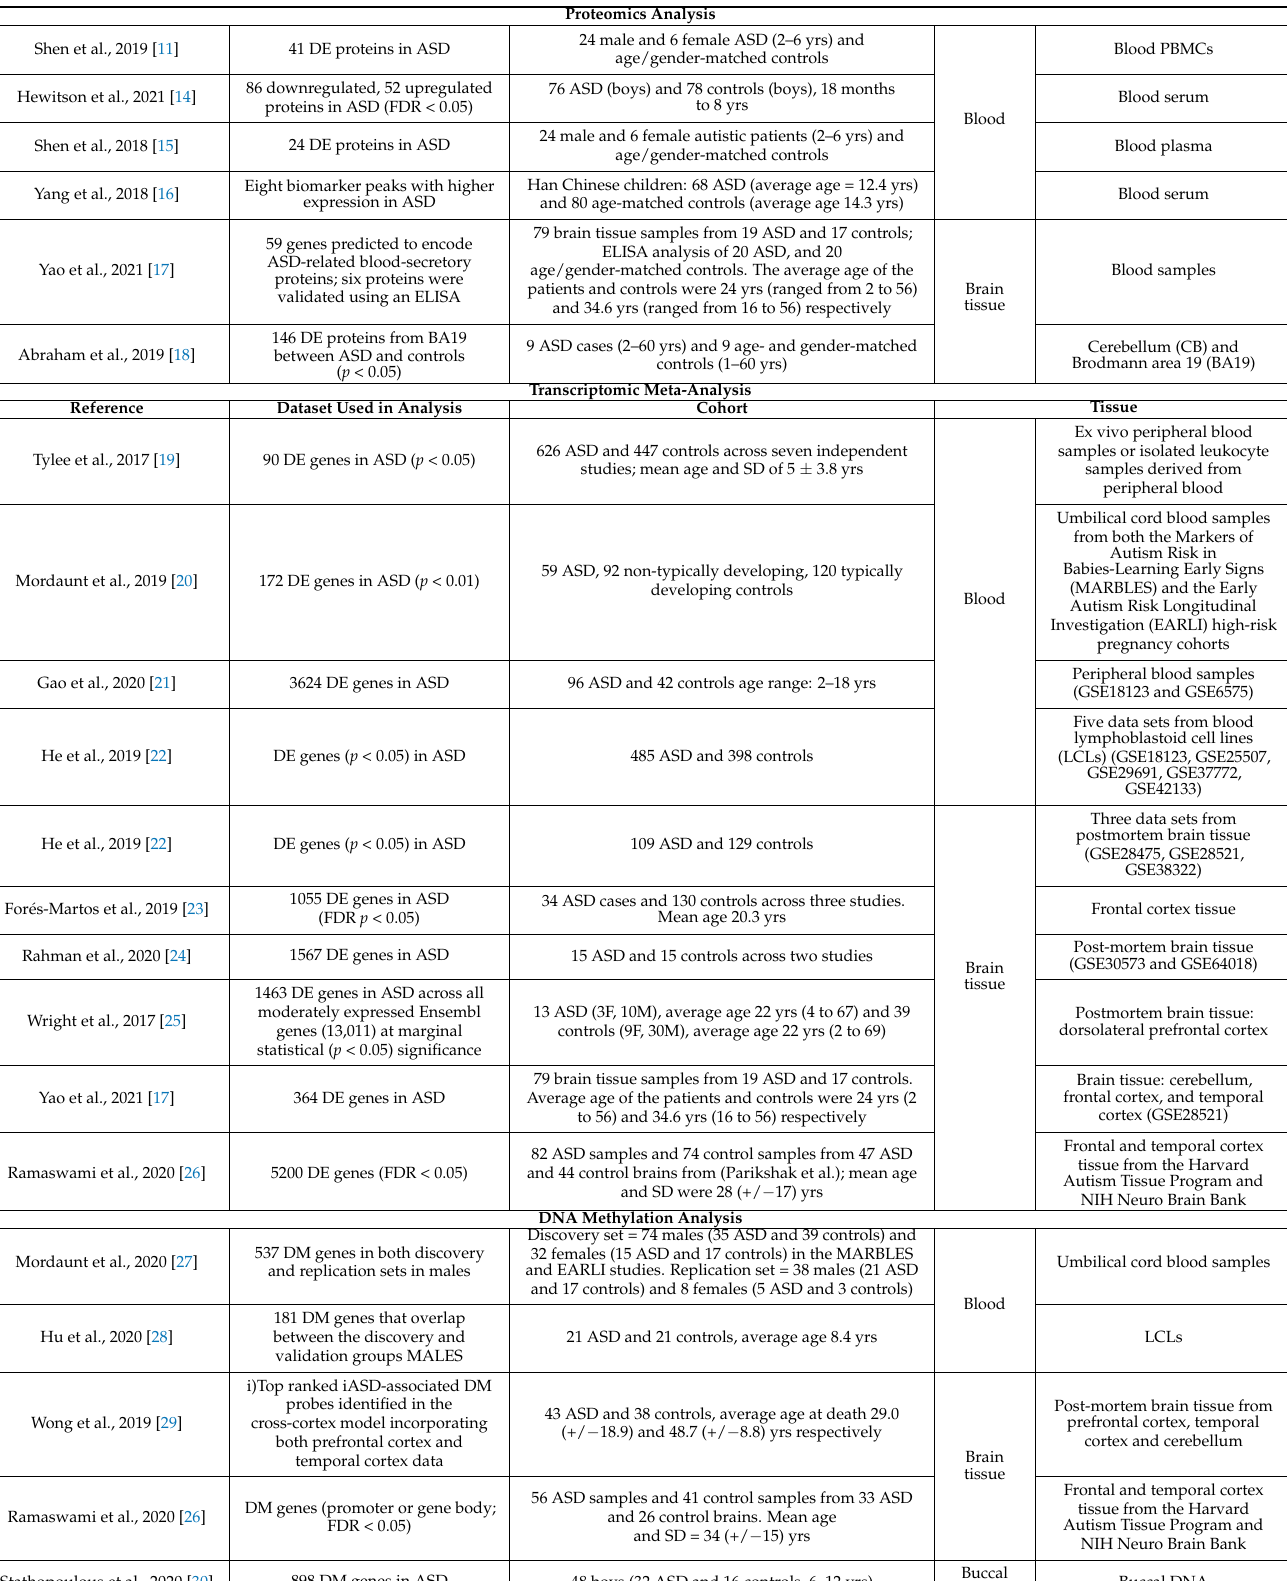
Table 1. A description of the 19 datasets included in this review, summarizing the type of study, the cohort size, the tissue type, and the definition of the final dataset used from each study. DE = differentially expressed; DM = differentially